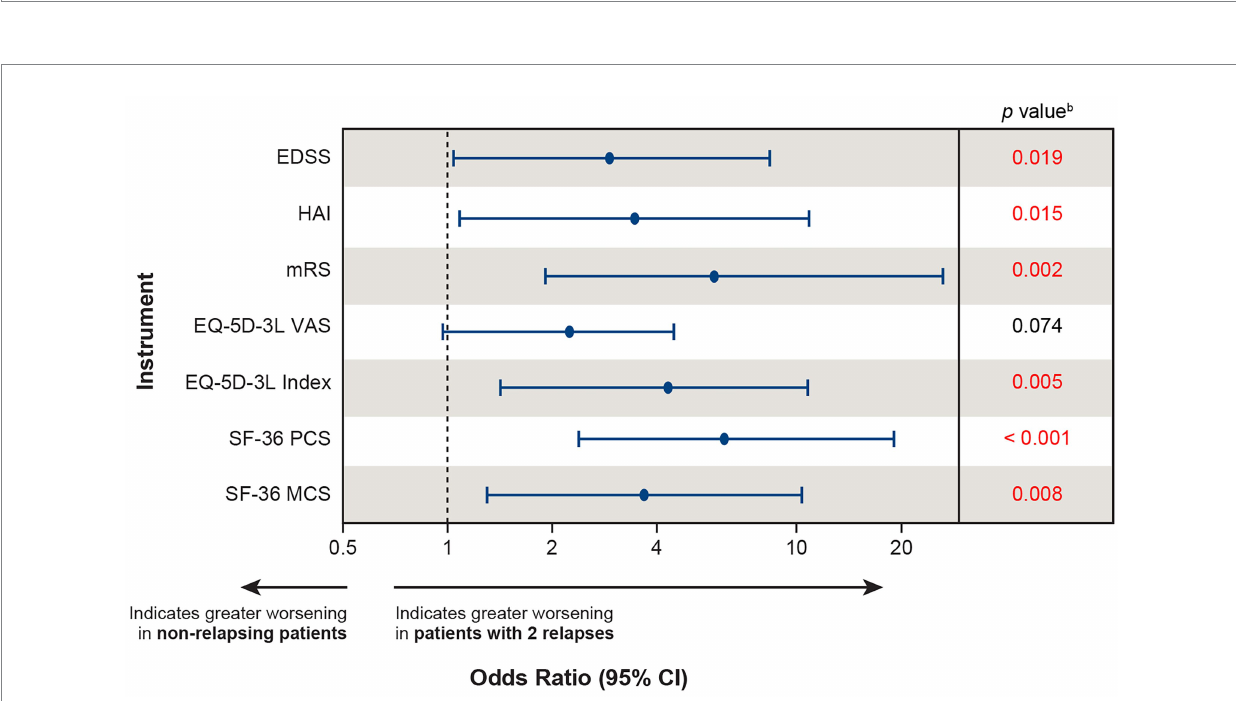
FIGURE 5 Extrapolating a the likelihood of clinically meaningful worsening in patients experiencing 2 relapses versus non-relapsing patients. a The effect of 2 relapses was estimated by doubling the effect of the first relapse on each instrument using baseline values from the PREVENT study and calculating the likelihood of clinically meaningful worsening between patients with 2 relapses versus non-relapsing patients. b Red font indicates p < 0.05. CI, confidence interval; EDSS, Expanded Disability Status Scale; EQ-5D-3L, European Quality of Life 5-Dimension questionnaire 3-level; HAI, Hauser Ambulation Index; MCS, mental component summary; mRS, modified Rankin scale; OLE, open-label extension; PCS, physical component summary; PREVENT, Prevention of Relapses in Neuromyelitis Optica; SF-36, 36-Item Short-Form Health Survey; VAS, visual analogue